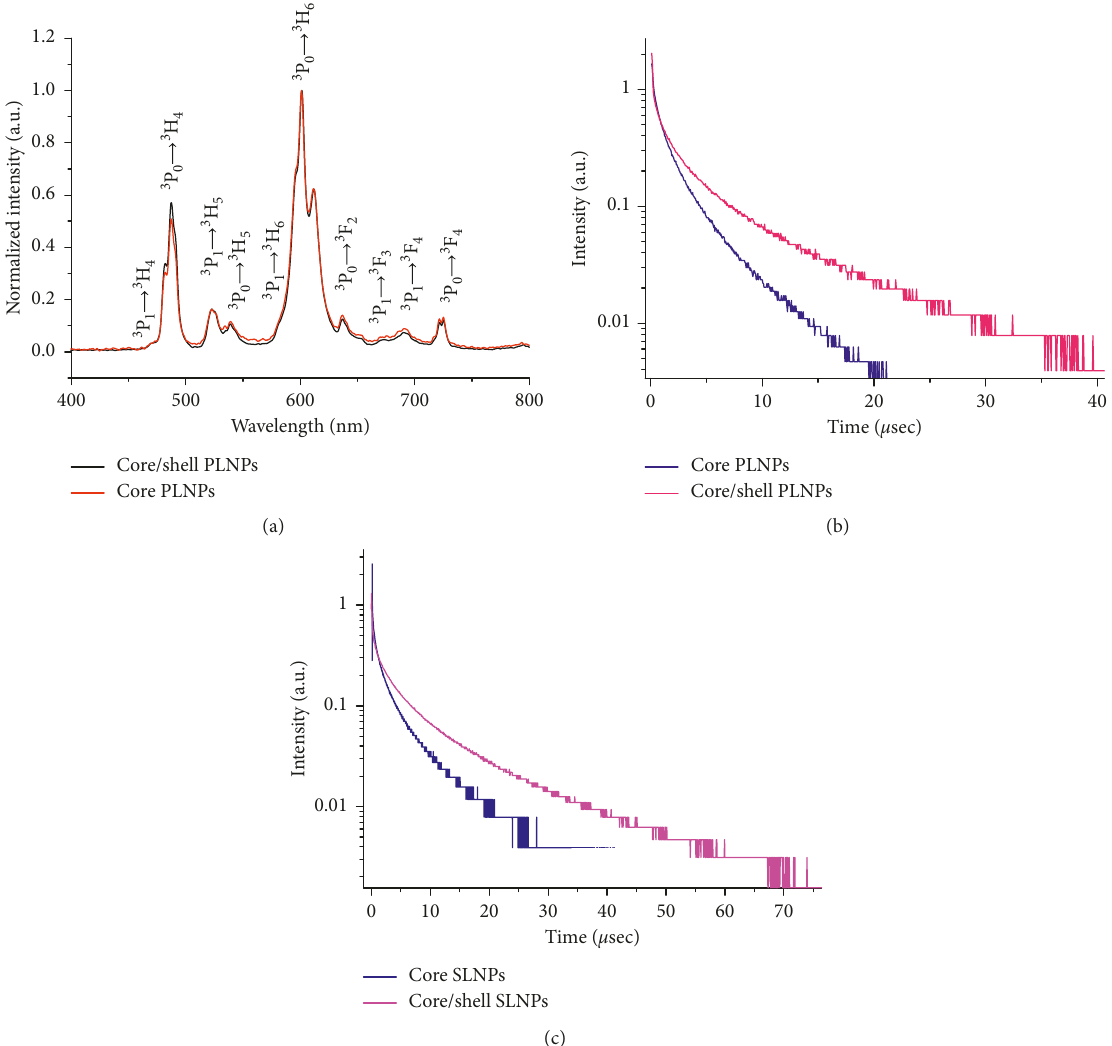
Figure 6: (a) Normalized at maximum (601nm) room-temperature luminescence spectra of both core nanoplates and core/shell nanoplates ( λ ex � 444nm). (b) The luminescence lifetime curves of the 3 P 0 state of Pr 3+ for core nanoplates and core/shell nanoplates at 300K ( λ ex � 444nm, λ em � 486nm). (c) The luminescence lifetime curves of the 3 P 0 state of Pr 3+ for core nanospheres and core/shell nanospheres at 300K ( λ ex � 444nm, λ em �